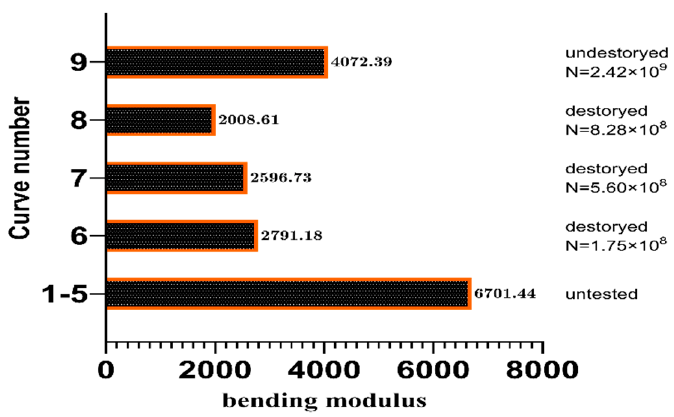
Figure 16. Flexural modulus of the CFRP specimens tested.